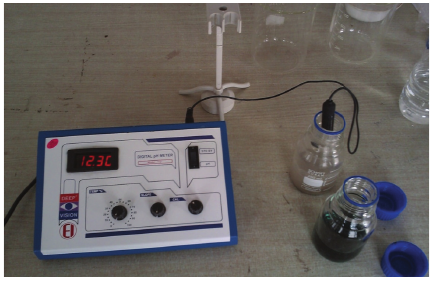
Figure 3: Sorptivity test.